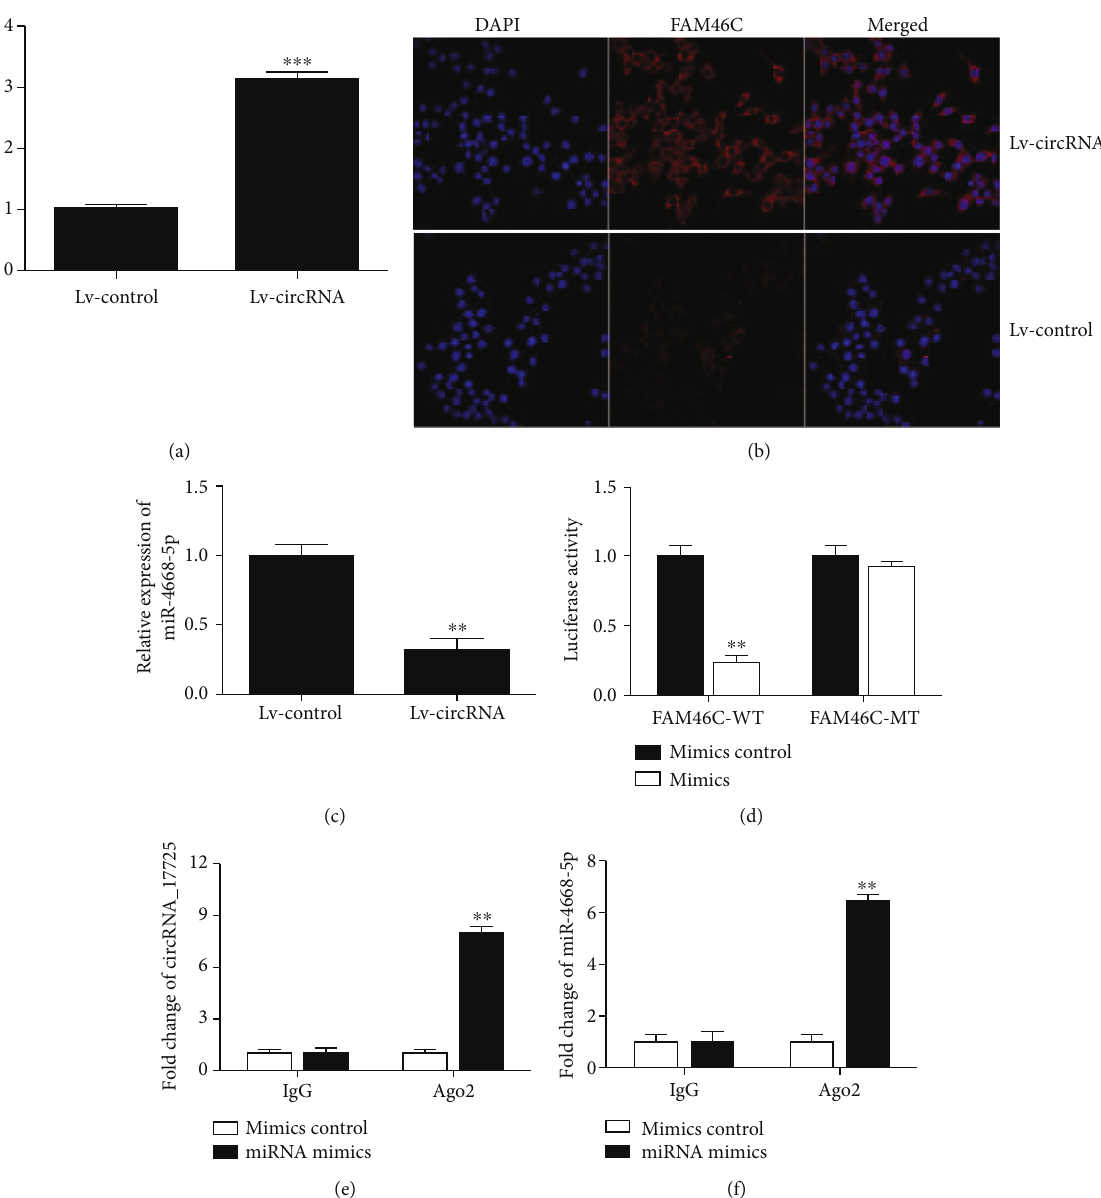
Figure 7: circRNA_17725 functioned as a ceRNA based on the circRNA_17725-miR-4668-5p-FAM46C network. (a) Real-time PCR: increased expression of FAM46C in Lv-circRNA-transfected Raw264.7 macrophages ( ∗∗∗ P < 0 : 001 ; n = 3 ). (b) Cell immuno fl uorescence: higher expression of FAM46C in Raw264.7 macrophages transfected by Lv-circRNA plasmids (representative pictures; 20x). (c) Real- time PCR: decreased miR-4668-5p in Lv-circRNA-treated cells ( ∗∗ P < 0 : 01 ; n = 3 ). (d) Luciferase reporter assay: miR-4668-5p mimics inhibited FAM46C expression in macrophages ( ∗∗ P < 0 : 01 ; n = 3 ). (e) RIP test: expression of circRNA_17725 in immunoprecipitations ( ∗∗ P < 0 : 01 ; n = 3 ). (f) RIP test: expression of miR-4668-5p in immunoprecipitations ( ∗∗ P < 0 : 01 ; n = 3